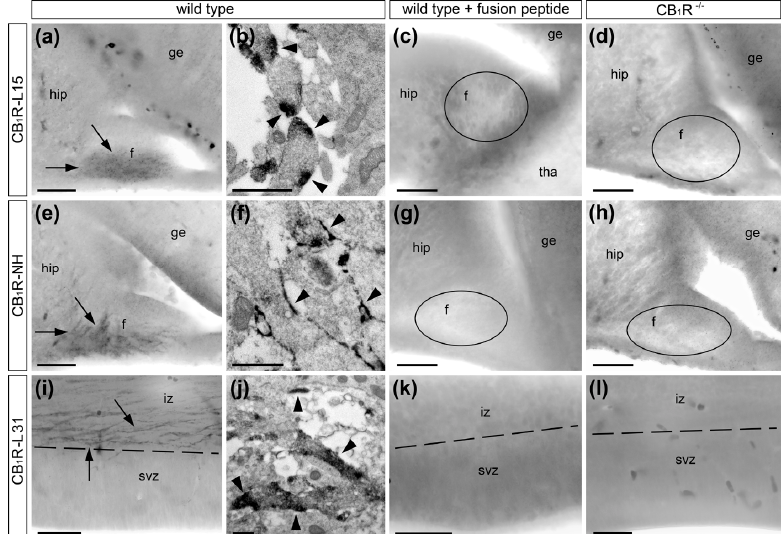
Figure 3. Immunoperoxidase DAB-Ni labeling with CB 1 R-L15 serum in E15 mouse telencephalon. ( a , b ) Only axon bundles (arrows) in IZ of the cerebral cortex (crt) and fimbria ( f ) represent selective CB 1 R labeling in wild type embryo as they are immunonegative in the CB 1 R − / − embryo at the same labeling conditions. Radial processes in the dorsal thalamus (tha), ganglionic eminences (ge), cerebral cortex and hippocampus (hip) show non-selective labeling that is similar in wild type and CB 1 R − / − embryos as further confirmed with high power light microscopy images from middle segments of the dorsal thalamus ( c , d ) and radial glia cell end-feet (arrowheads) on the pial surface of the lateral ganglionic eminence ( e , f ). Scale bars: ( a , b ) 100 μ m and ( c – f ) 20 μ m. Int. J. Mol. Sci. 2020 , 21 , x FOR PEER REVIEW